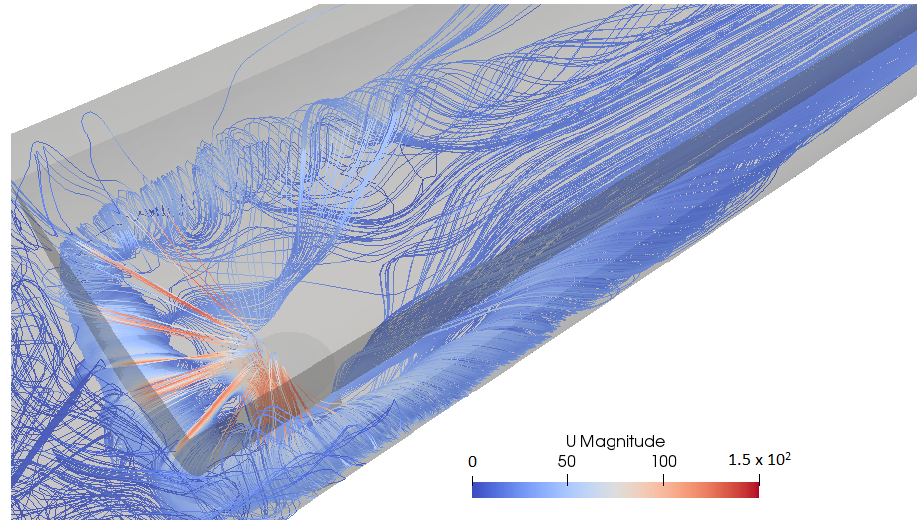
Figure 9. Vortices around the releasing mass surface in the first part of the annular region visualized by velocity streamlines ( d = 0.77 mm, L = 32.2 mm, D = 3.6